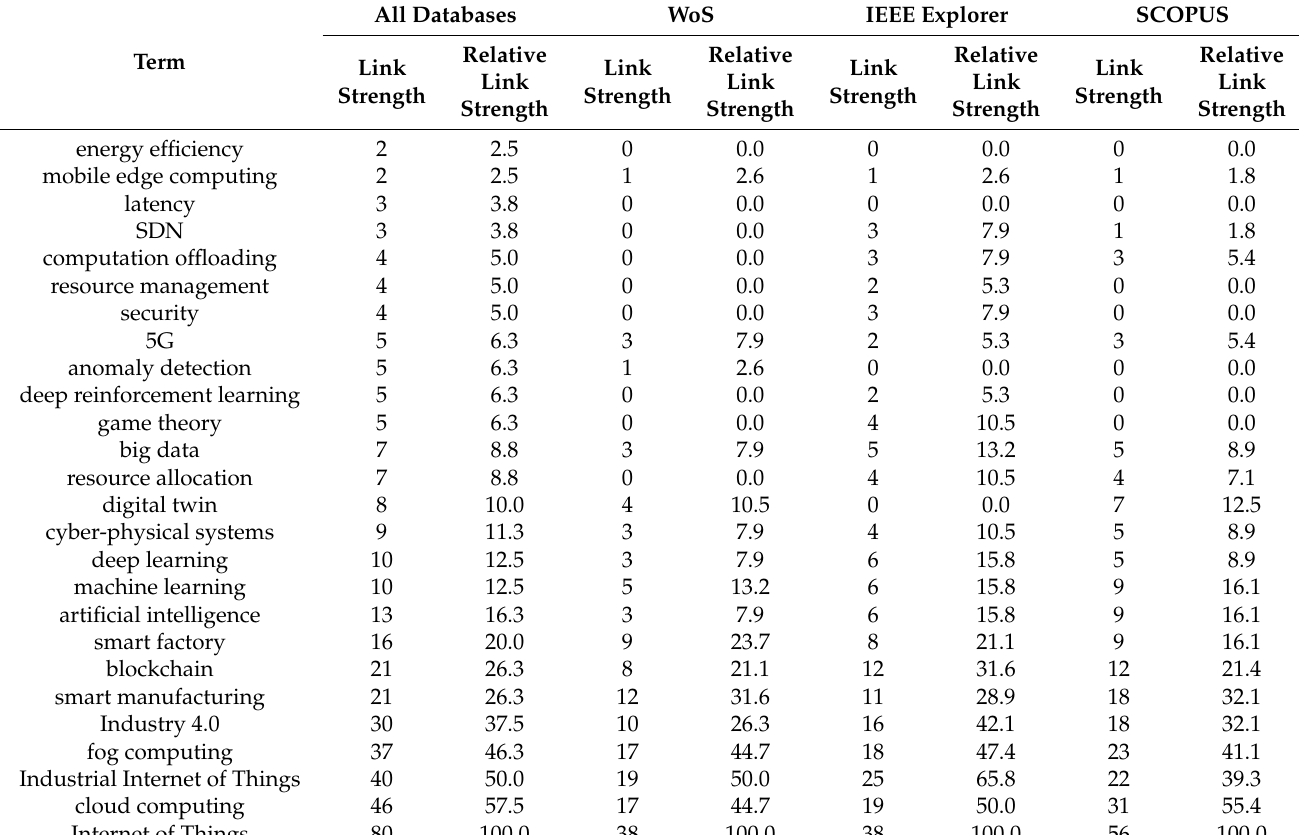
Table 6. Link strength between a term and the Edge Computing